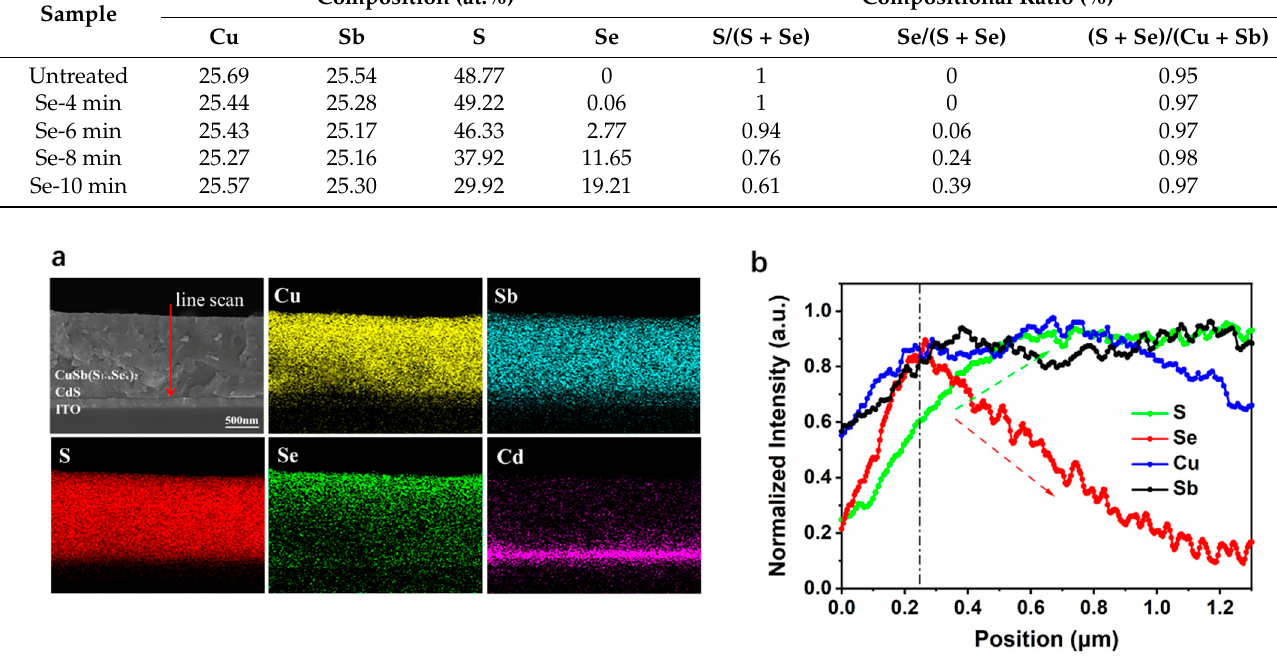
Figure 5. Quantitative elemental analysis: ( a ) EDS elemental mapping and ( b ) Element distribution in CuSbS 2 (Se) selenized for 8 min. Table 3. Global elemental analysis of Cu, Sb, S, and Se elements in CuSbS 2 (Se) samples selenized for different durations.